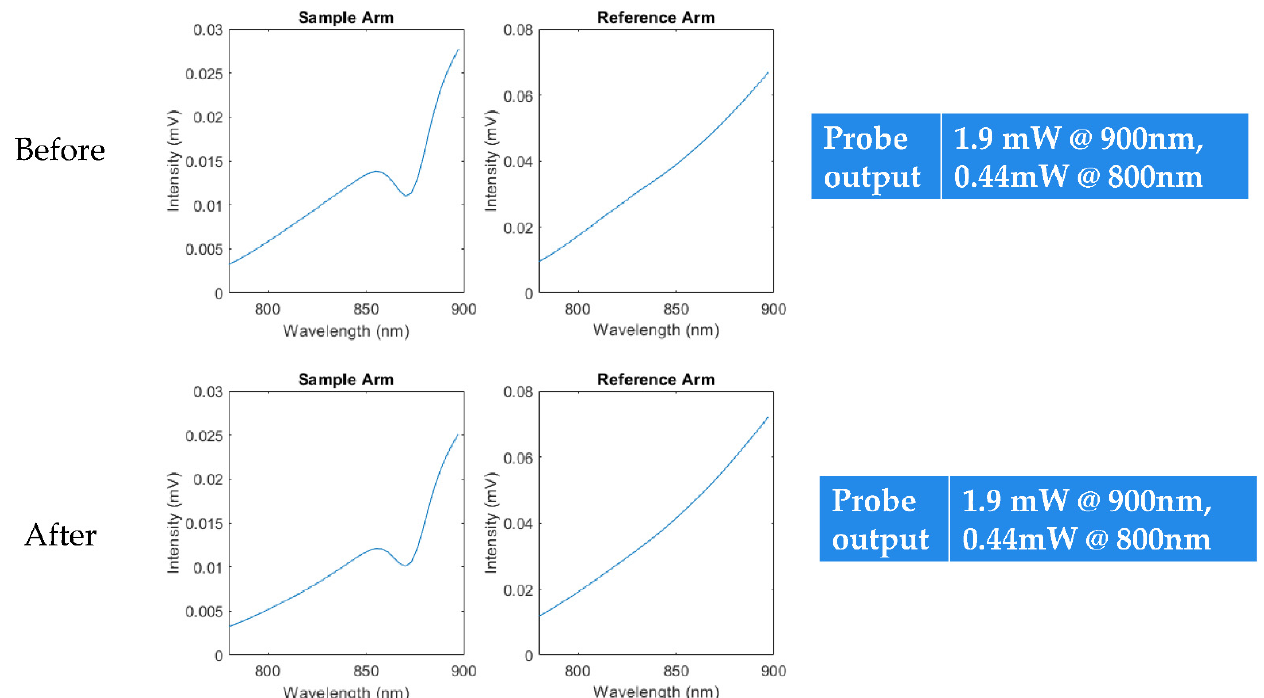
Figure 27. Spectrum and power comparison before and after road driving test (local roads and dirt roads). The left curves are the sample arm spectra, and right curves are the reference arm spectra.